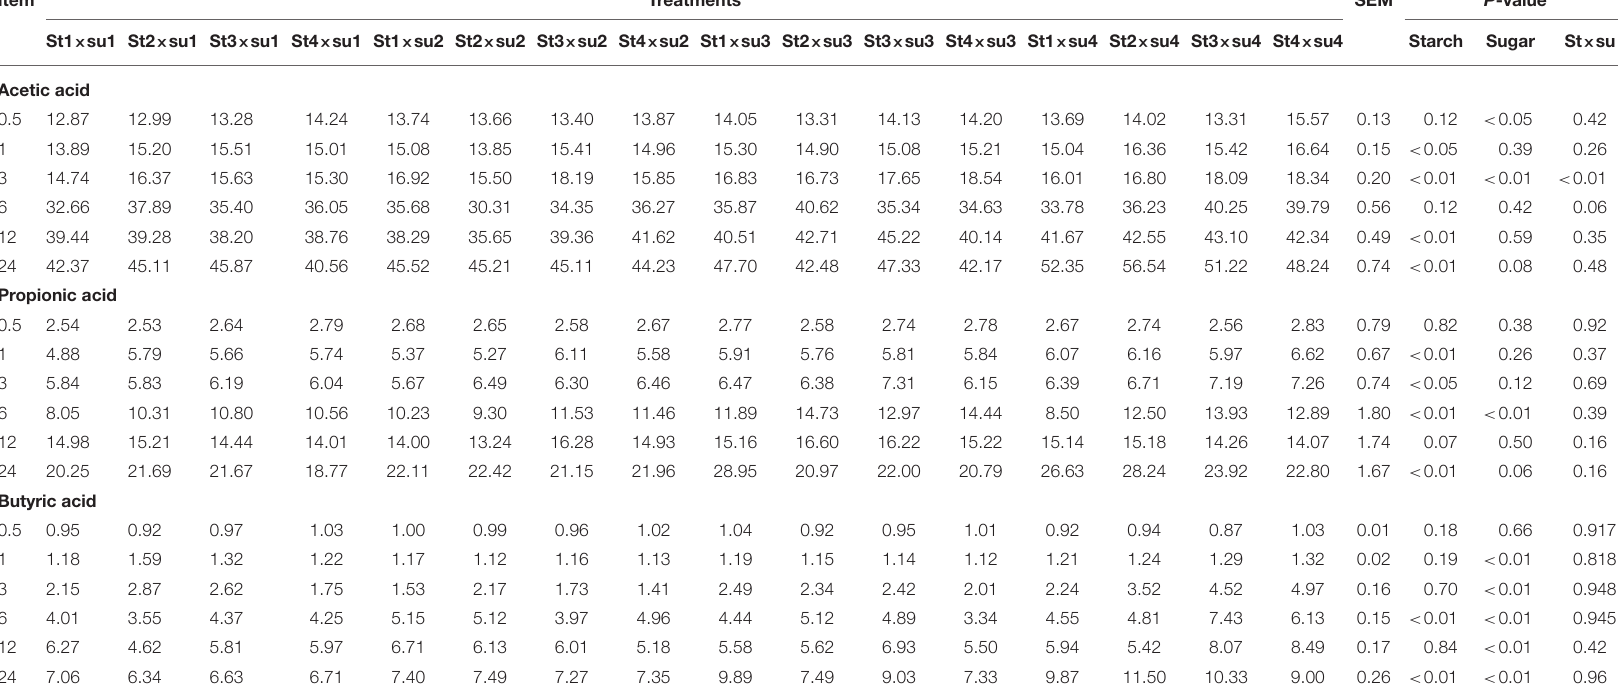
TABLE 2 | Comparison of VFA concentration (mmol/L) in each